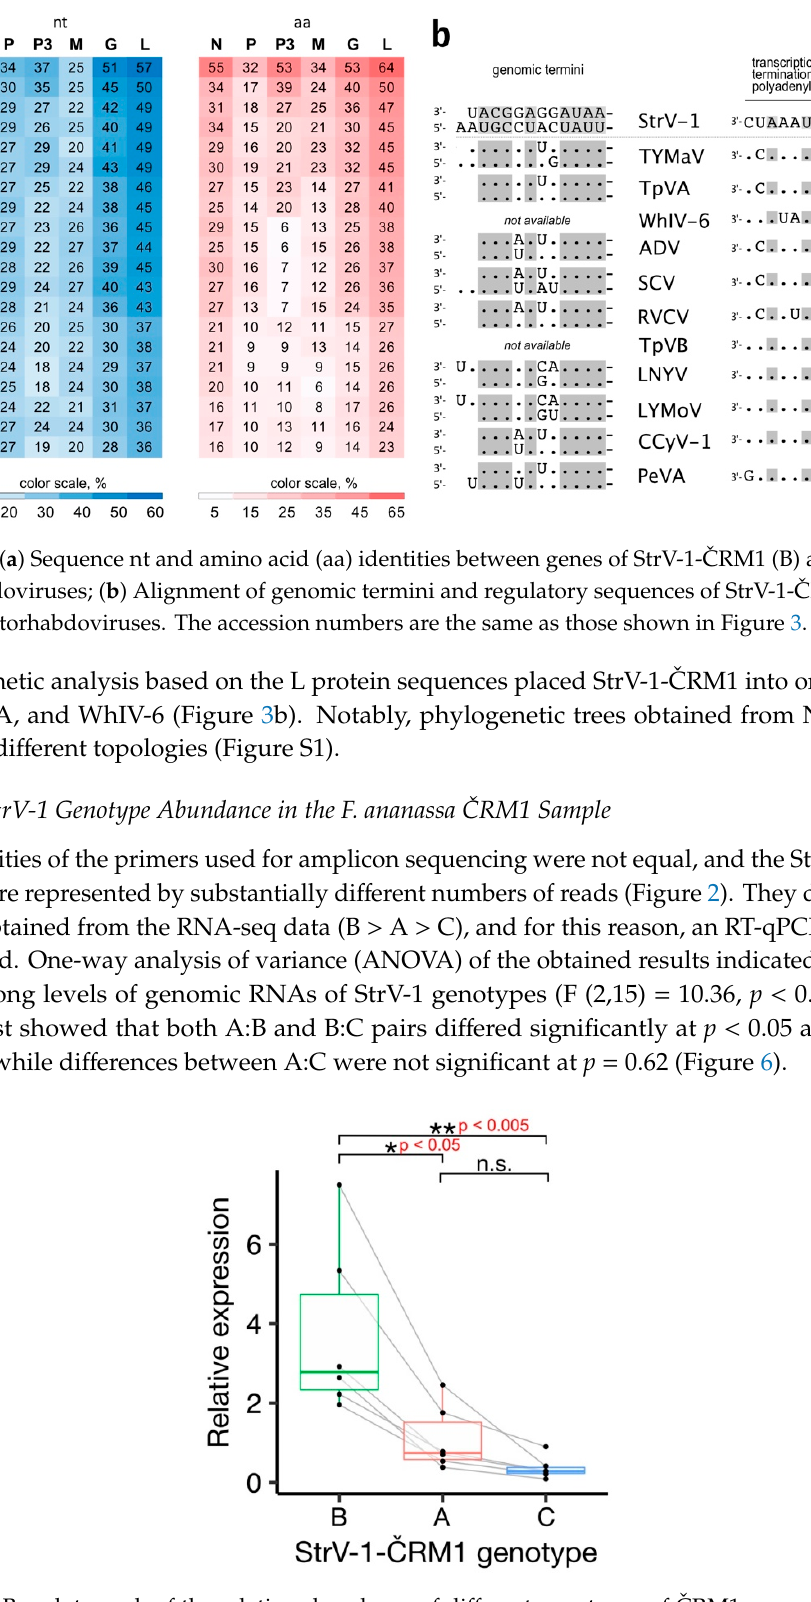
Figure 6. Boxplot graph of the relative abundance of different genotypes of Č RM1 genomic RNAs within individual biological replicates of the Č RM1 isolate of F. ananassa . Strawberry crinkle virus was used as a reference. Grey lines connect data points obtained from the same biological replicate.